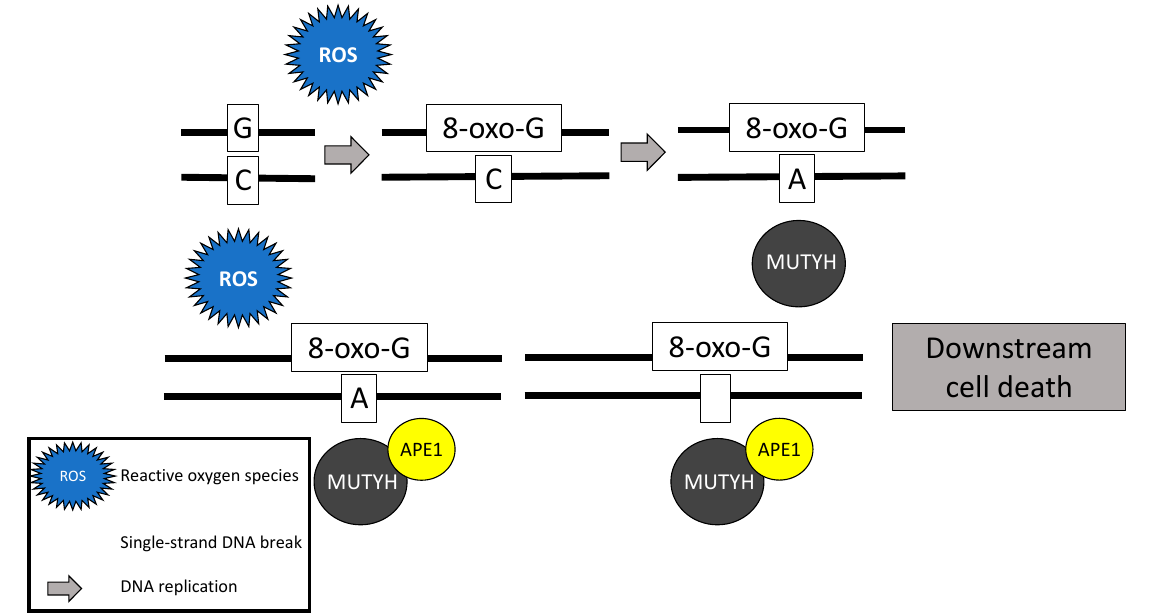
Figure 1. Base excision repair mechanism of the MutY homolog ( MUTYH ) in response to oxidative damage.